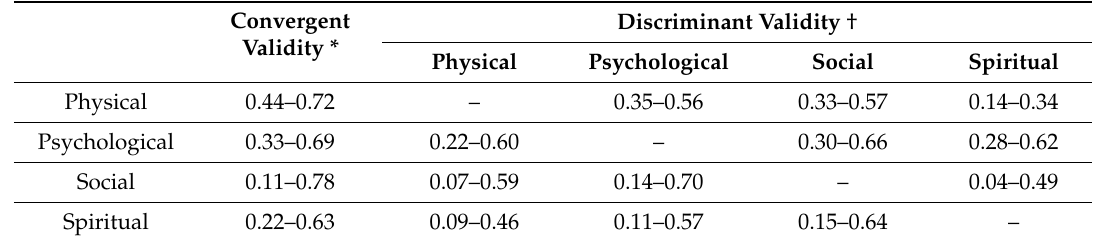
Table 3. Convergent and discriminant validity indicators.